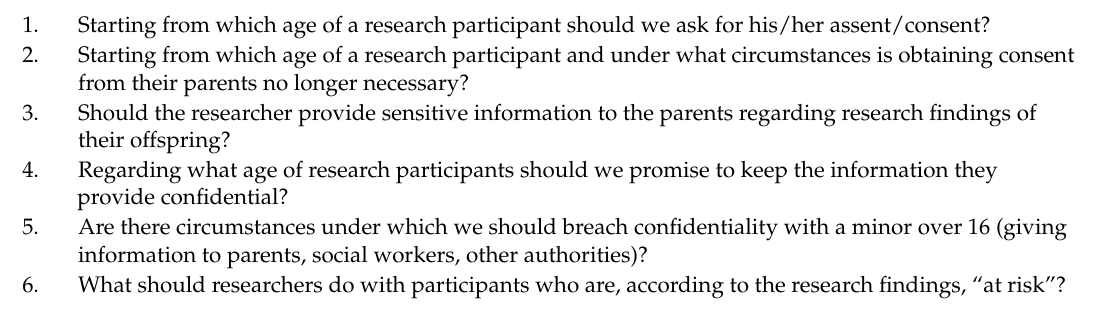
Table 1. Preliminary List of Ethical Issues of